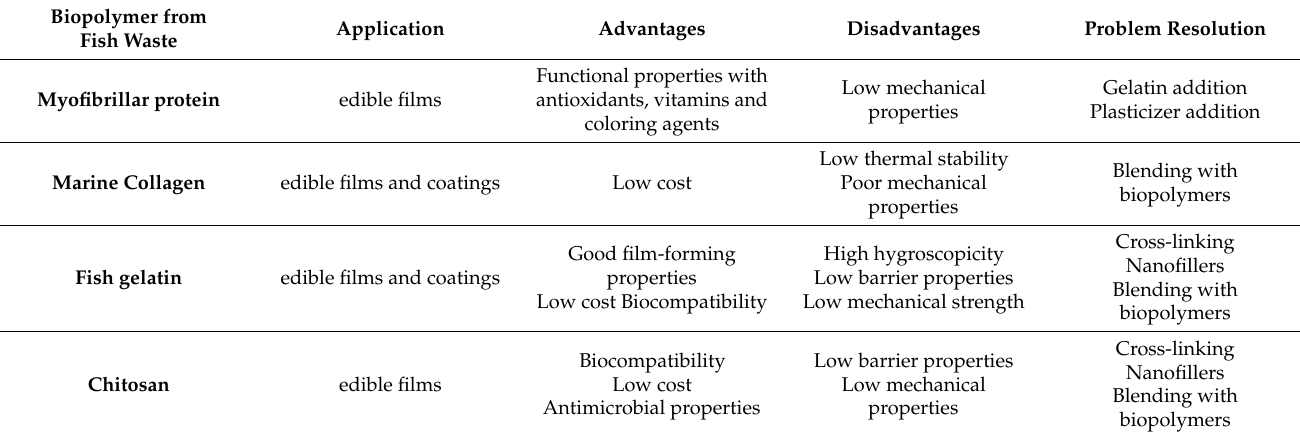
Table 3. Biopolymers derived from fish waste: principal applications in food packaging, advantages, disadvantages and strategies for problem resolution. Biopolymer from Fish